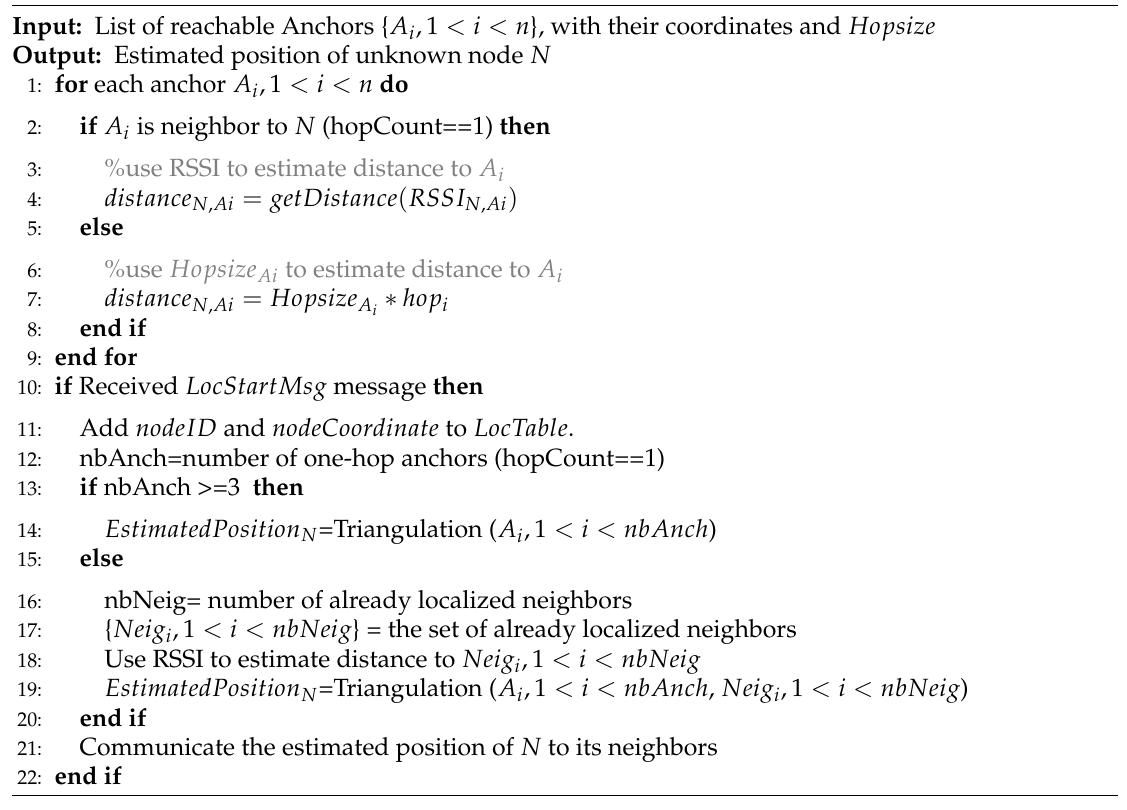
Algorithm 1 Proposed Algorithm (Hybrid